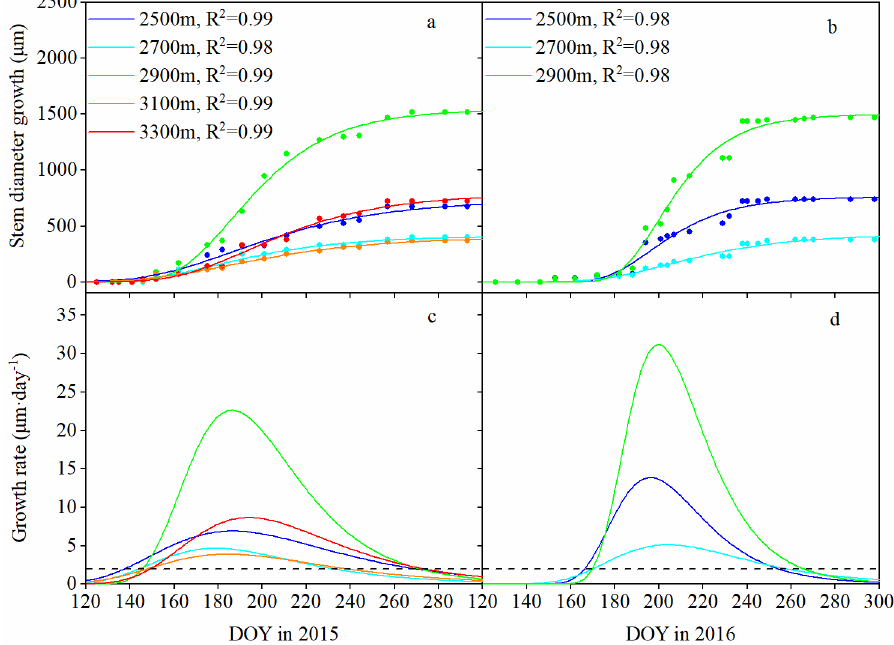
Figure 3. Gompertz function-modeled curves of the cumulative stem growth ( a , b ) and daily growth rate ( c , d ) at different elevations during the growing seasons of 2015 and 2016 (May–October). The dashed lines at the bottom panels indicate the daily growth rate (equal to 2 μ m·day − 1 ).